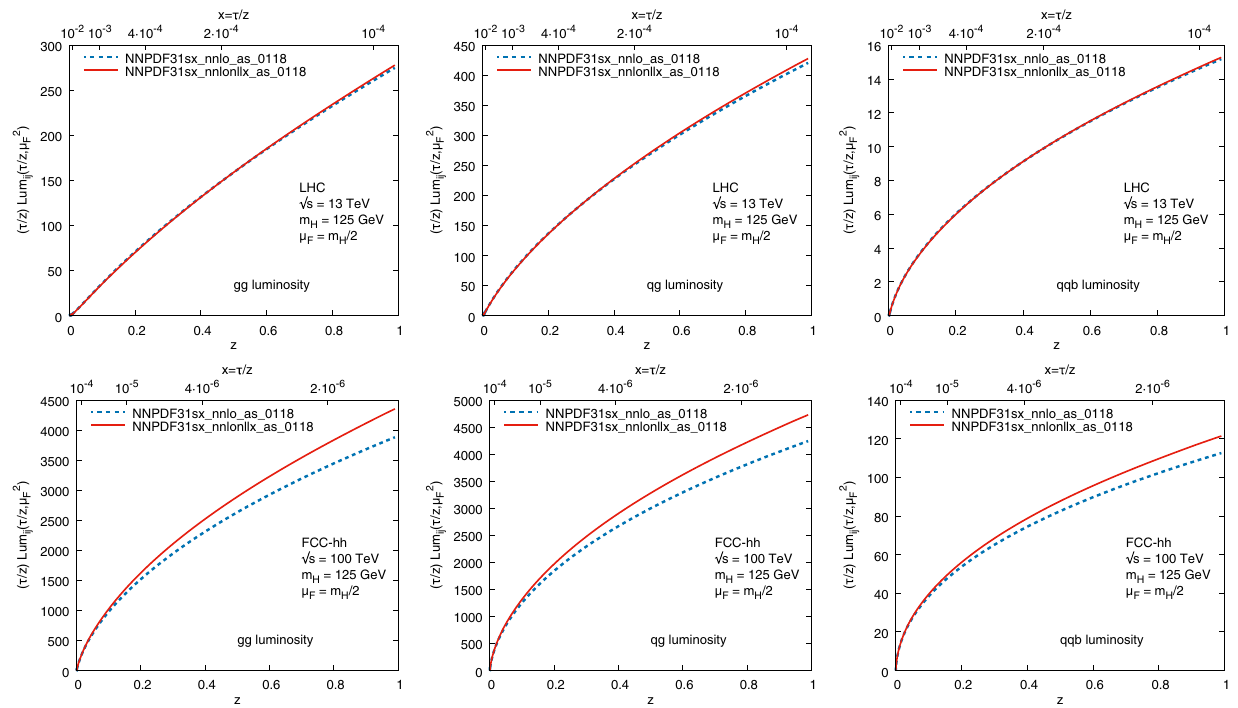
) for x = τ/ z as a function of z , Fig. 6 The luminosities x L ij ( x ,μ 2 F for ij = gg (left plot), ij = qg (middle plot) and ij = q ¯ q (right plot), √ s = 13 TeV (top row) and FCC-hh for Higgs production at LHC at √ s = 100 TeV (bottom row). Values of x = τ/ z are shown in the at